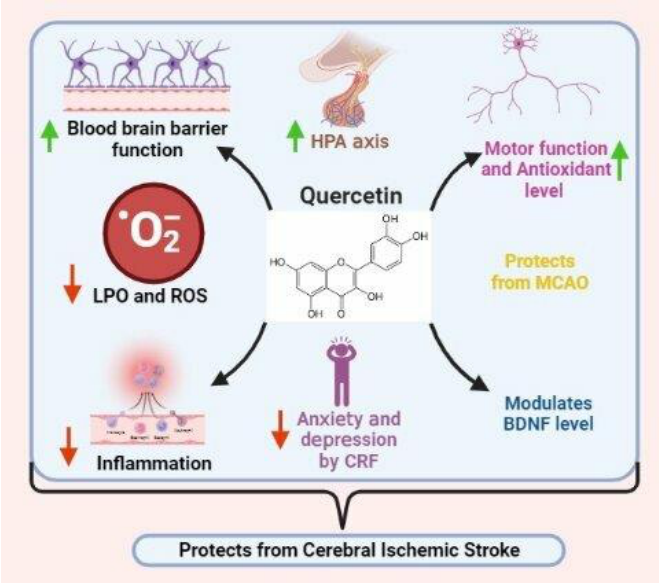
Figure 3. Effects of quercetin on ischemic stroke (image created using biorender.com (accessed on 21 October